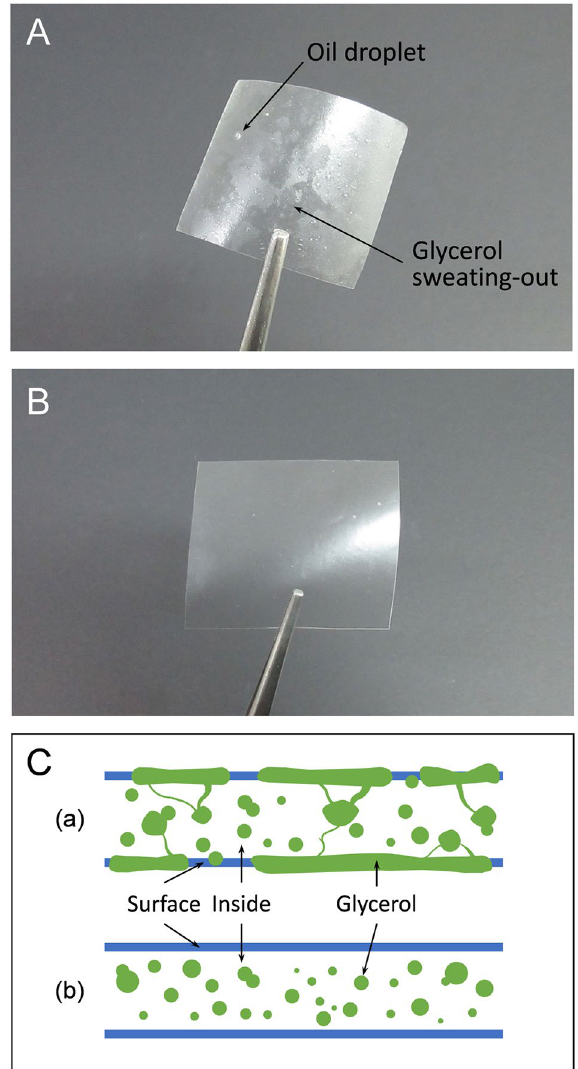
SSO sunflower seed